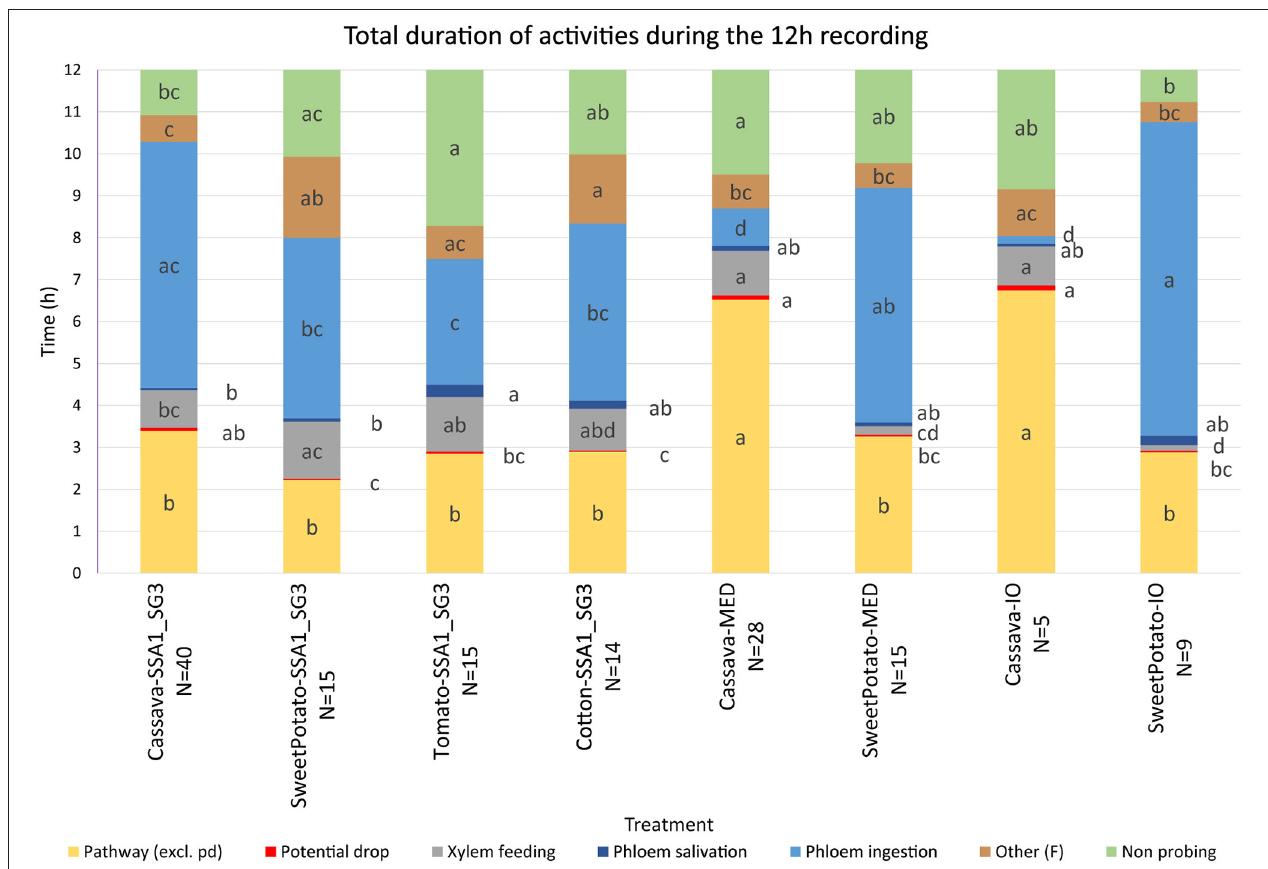
FIGURE 3 | Total duration of activities during the 12-h recording period. Statistical analysis was performed after transformation, data presented is on the original scale. Letter display was obtained by the method of Piepho (2012) from PROC GLIMMIX output. Values with the same letter are not significantly different ( P = 0.05, Tukey-Kramer test). The number of SSA1-SG3 individuals was 40, 15, 15, and 14 on cassava, sweet potato, tomato, and cotton hosts, respectively, 28 and 15 of MED on cassava and sweet potato, respectively, and 5 and 9 of IO individuals on cassava and sweet potato,